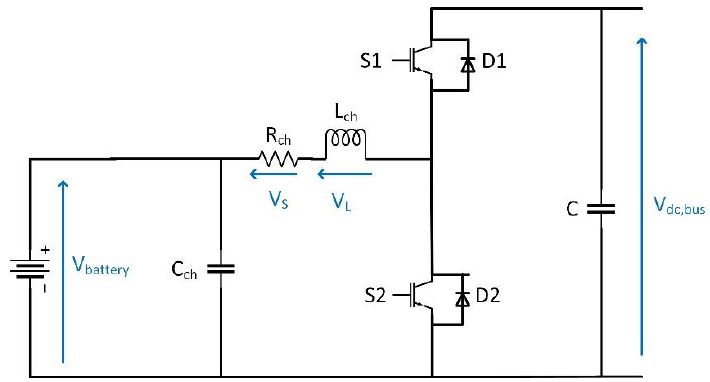
Figure 2. The bidirectional half-bridge DC-DC converter. Reprint with permission [29]; 2020, IEEE.